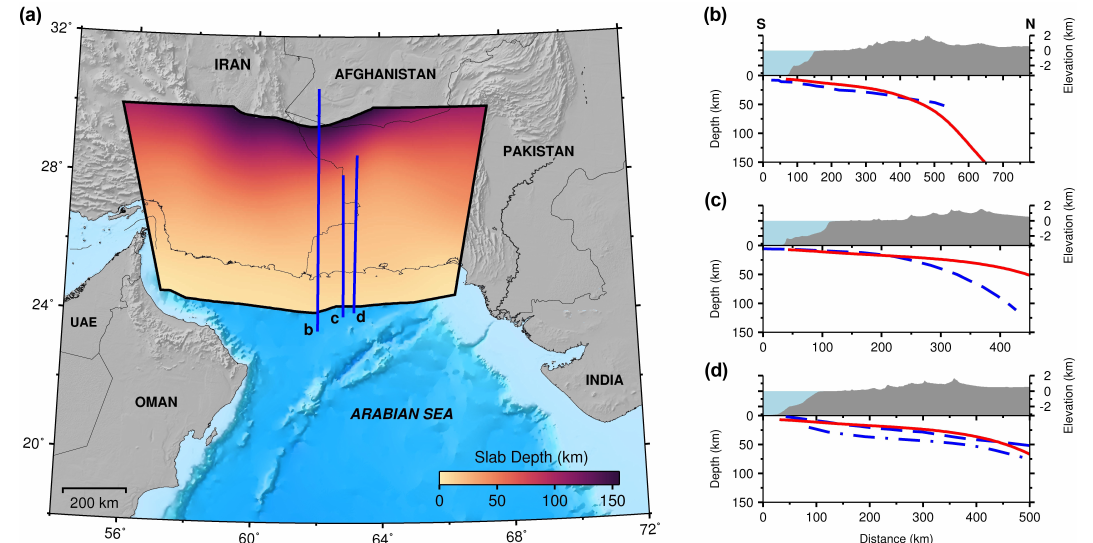
Figure 14. ( a ) Slab2 model for the Makran subduction zone presented by Hayes et al. [143]. Solid blue “a”, “b” and “c” lines are profiles from Penney et al. [1], Smith et al. [11] and Frohling and Szeliga [15], respectively, which denote the cross sections of plate interfaces. ( b ) Profile “b” showing cross sections of the plate interface from Penney et al. [1] (dashed blue line) and the Slab2 model (red line). ( c ) Profile “c” showing cross sections of the plate interface from Smith et al. [11] (dashed blue line) and the Slab2 model (red line). ( d ) Profile “d” showing cross sections of the plate interfaces from Frohling and Szeliga [15] (shallow, dashed blue line; deep, dash-dotted blue line) and the Slab2 model (red